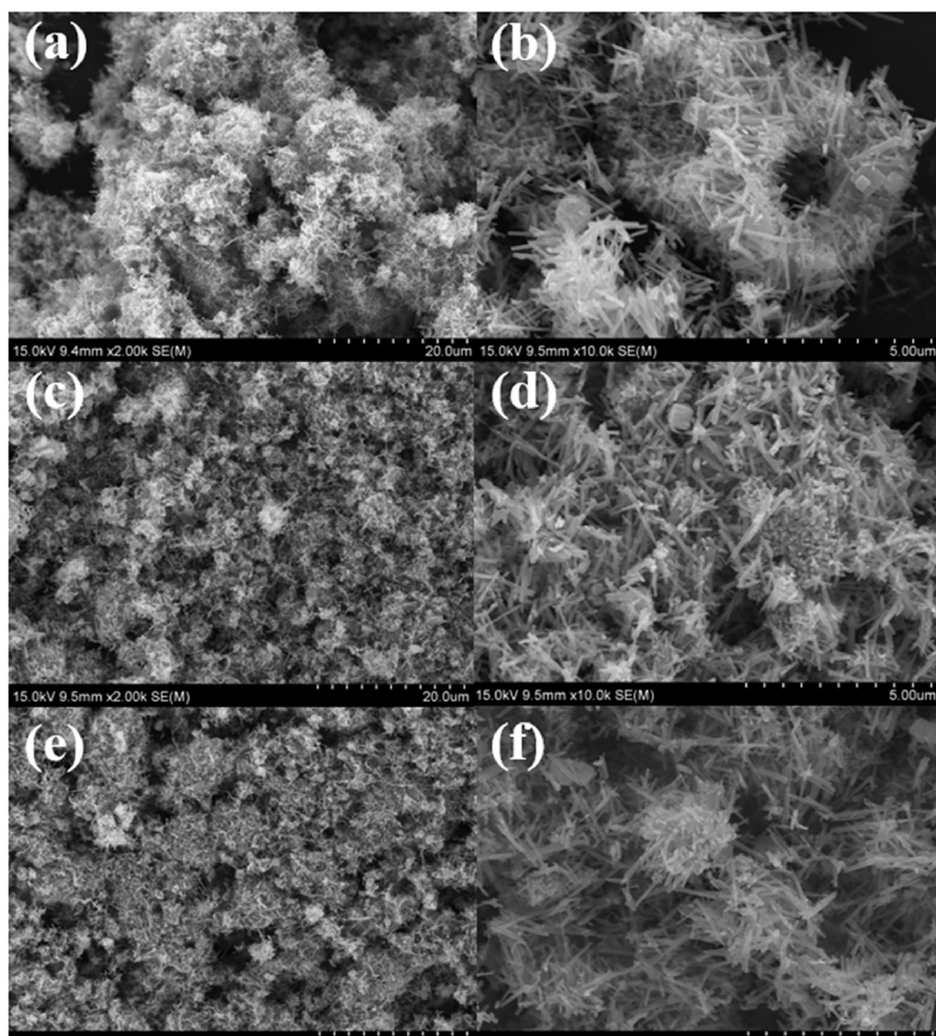
Figure 9. SEM images of the as-prepared catalysts: ( a , b ) Cu 2 O/ α -MnO 2 , ( c , d ) Cu 2 O-CuO/ α -MnO 2 -260, and ( e , f ) CuO/ α -MnO 2 -500.